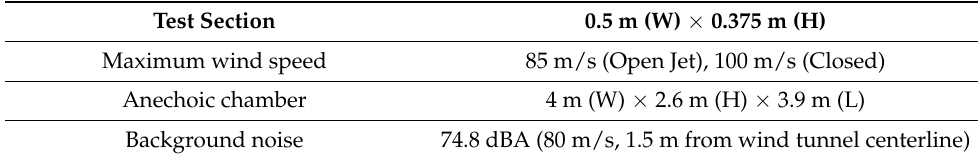
Table 1. Performance parameters of 0.5 m anechoic wind